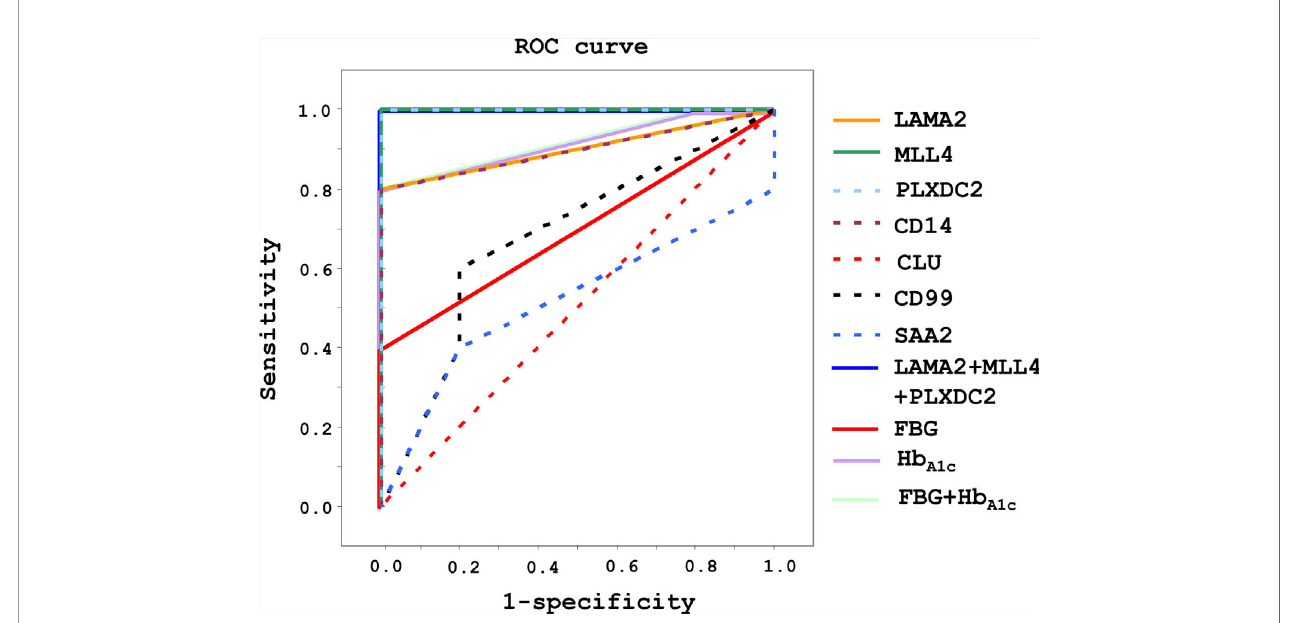
FIGURE 5 | Diagnostic ef fi cacy and value of LAMA2, MLL4, PLXDC2, CD14, CLU, CD99 and SAA2 in healthy and pre-diabetic sera of human origin. After immunoblotting analysis, diagnosis ef fi cacy was analyzed using a ROC curve. Sensitivity, speci fi city, and accuracy were evaluated for diagnostic value. TABLE 1 | Diagnostic value of serum LAMA2, MLL4, PLXDC2, CD14, CLU, CD99 and SAA2, FBG and Hb A1C level for pre-diabetes.